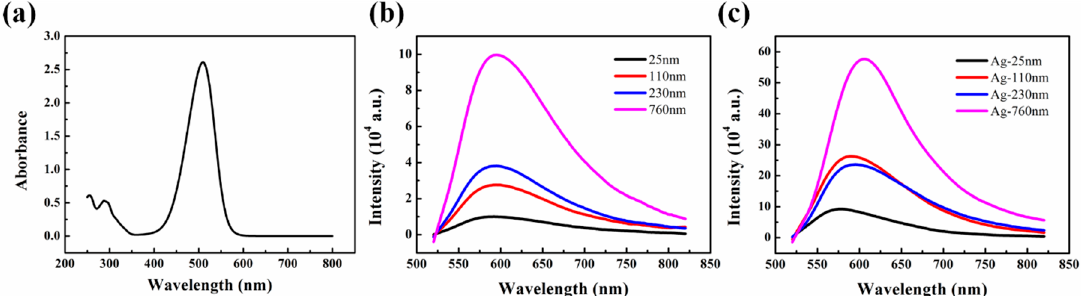
Figure 2. ( a ) UV absorption of TC1-labeled PMMA ( c = 1.92 mg/mL in tetrahydrofuran). Fluorescence emission spectrum of TC1-labeled PMMA with thickness of 25, 110, 230 and 760 nm on ( b ) quartz and ( c ) silver substrate.